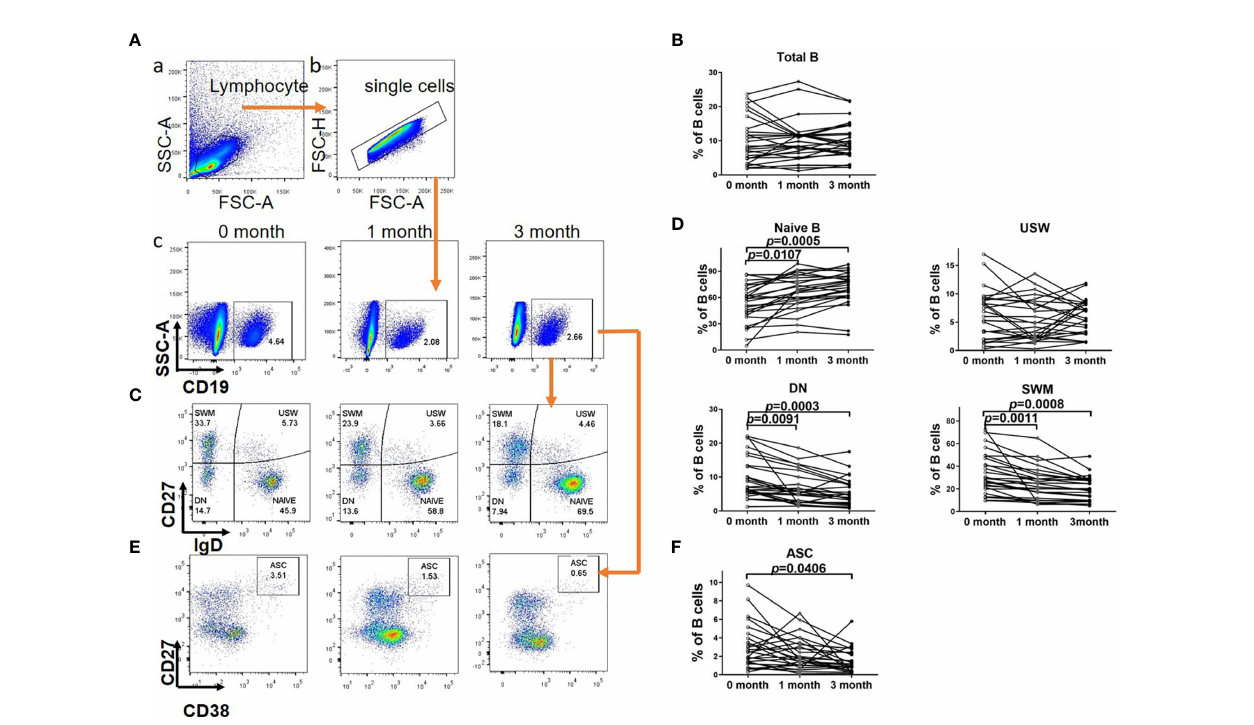
FIGURE 2 | B cell subsets distribution in NMOSD patients before and after tocilizumab. (A) Gating strategy for B subsets. (a) Sideward scatter-A (SSC-A) and Forward scatter-A (FSC-A) were used for lymphocytes gating. (b) FSC-H and FSC-A were used to gate single cells. (c) B cells was charactered by CD19 + . (B) Quantitative analysis of proportion of total B cells. The effect of tocilizumab treatment on these circulating B cell subsets was also assessed in NMOSD patients at baseline and after 1 month/3 months of treatment. (C, E) Representative fl ow cytometry of CD19 + CD27 – IgD + (naive), CD19 + CD27 – IgD – (double-negative, DN), CD19 + CD27 + IgD + (unswitched memory, USW), CD19 + CD27 + IgD – (switched memory, SWM) and CD19 + CD27 high CD38 high ASC (Autoantibodies secreted cells) from NMOSD patients before and after tocilizumab. (D, F) Quantitative analysis of proportion of B cell subsets and ASC. Signi fi cance was tested by repeated measures of analysis of variance and the Bonferroni – Dunn adjustment for multiple comparisons. Paired, two-tailed Student ’ s t tests (if the distribution is normal) or Wilcoxon matched pairs tests (If it does not conform to the normal distribution) were used to compare baseline and post-treatment results, n=26.